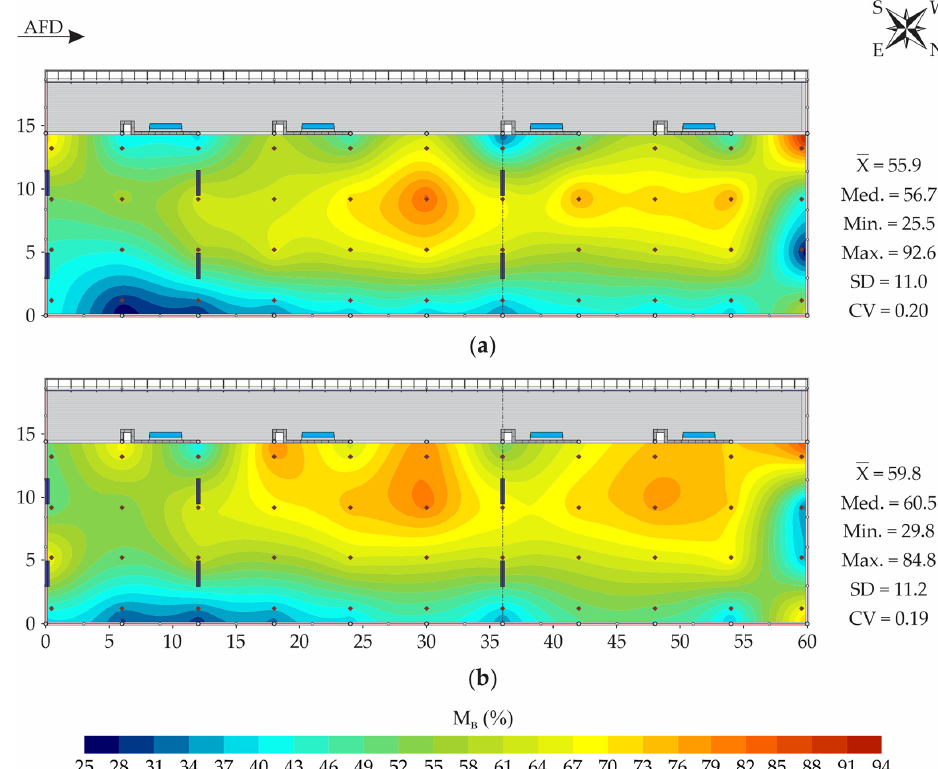
Figure 5. Spatial distribution of bedding moisture (M B , in %) at the surface—M B-sur ( a ) and at a depth of 0.2 m—M B-20 ( b ). AFD—air-flow direction; 𝑋 —mean; Med.—median; Min.—minimum; Max.—maximum; SD—standard deviation; CV—coefficient of variation.